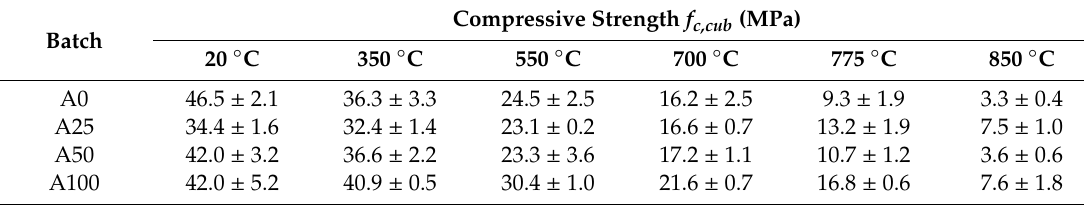
Table 4. Evolution of the compressive strength at high